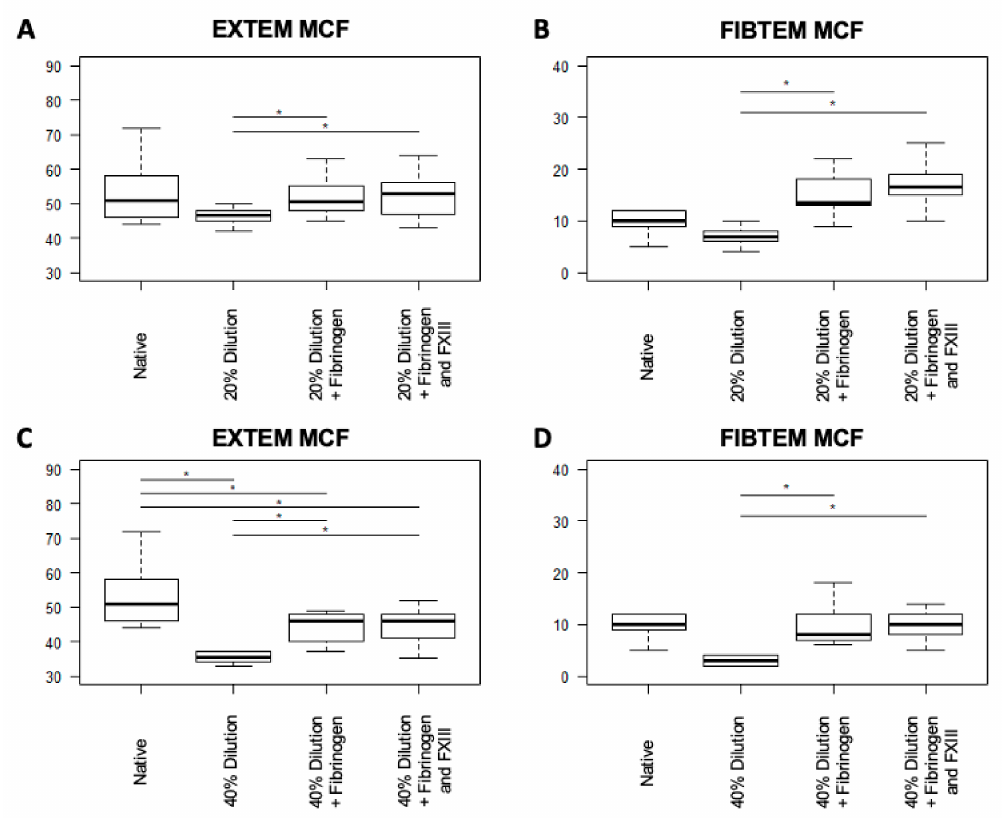
Figure 2. Boxplot diagram showing the results of the administration of fibrinogen and combined fibrinogen/FXIII to samples that were diluted by 20% ( A , B ) and 40% ( C , D ), respectively. Significant differences are highlighted with an asterisk (*: p <